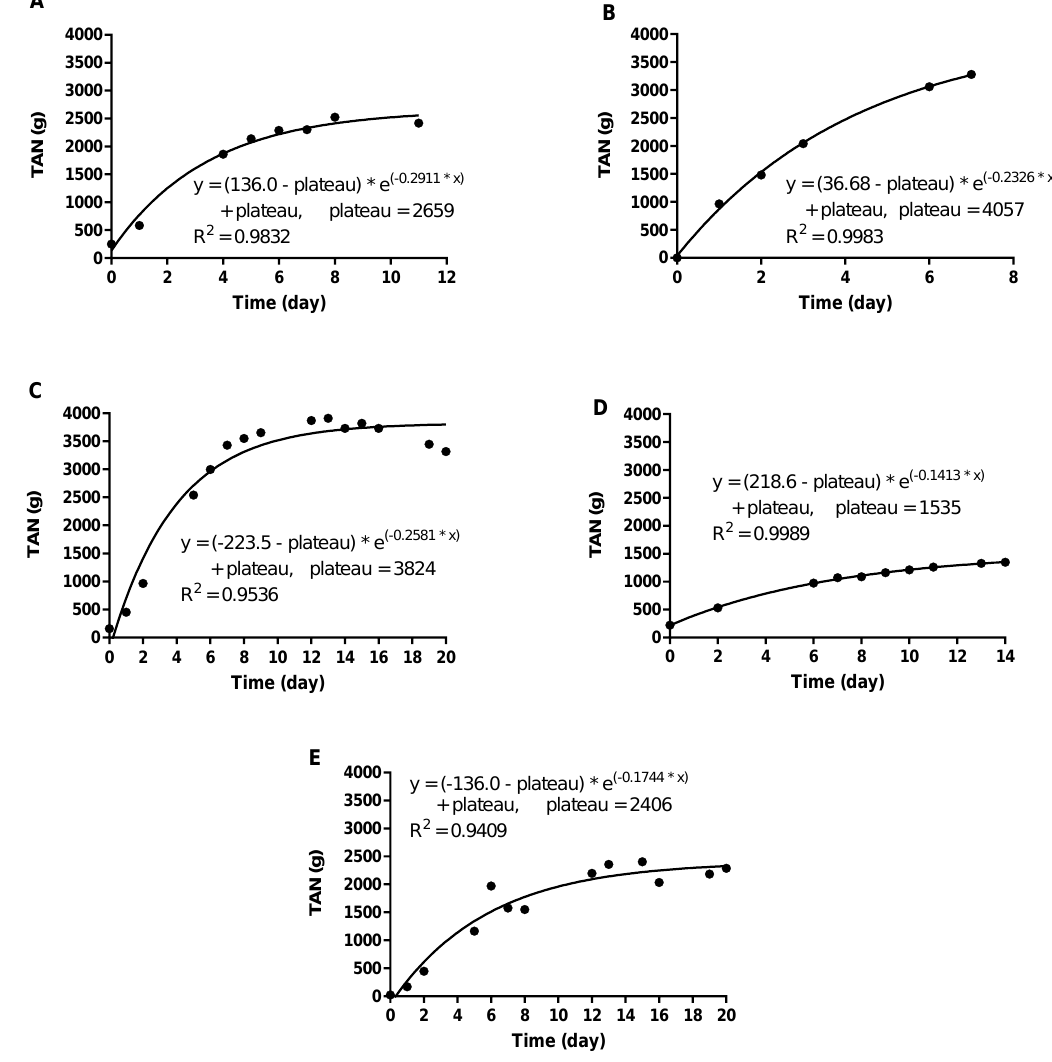
Figure 6. Mass of TAN in the trapping solution during B1 ( A ), B2 ( B ), B3 ( C ), B4 ( D ), and B5 ( E ).